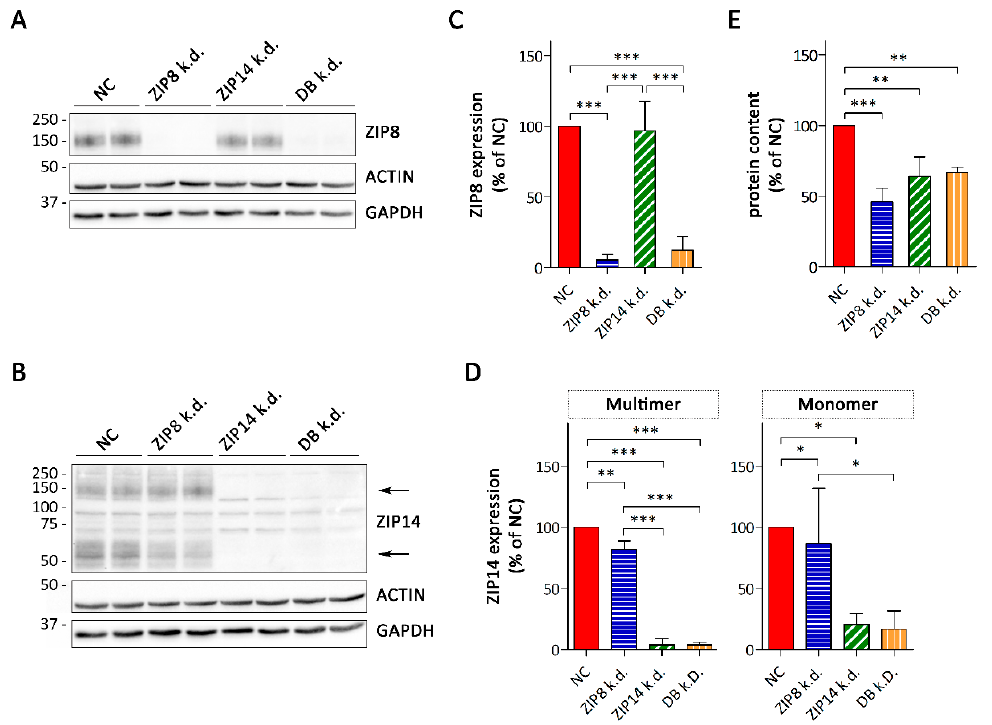
Figure 4. RNAi-mediated knockdown of ZIP8, ZIP14 or both in A549 cells. ( A ) ZIP8 and ( B ) ZIP14 immunoblot of whole-cell lysates confirming the knockdown of ZIP8 and ZIP14 (NC, scrambled control; DB, combined knockdown of ZIP8 and ZIP14). Both β -ACTIN and GAPDH were used as loading controls. The relative expression of ( C ) ZIP8 and ( D ) ZIP14 was determined by normalizing the band intensities to β -ACTIN. Data are presented as means ± SD from three independent experiments. Statistical analysis was performed using one-way ANOVA followed by the Bonferroni post-hoc test with ** p < 0.01 and *** p < 0.001. ( E ) Protein contents of A549 cultures. Data are presented as means ± SD from three independent experiments performed in duplicates. Statistical analysis was performed using one-way ANOVA followed by the Bonferroni post-hoc test with * p < 0.05, ** p < 0.01, and *** p < 0.001.